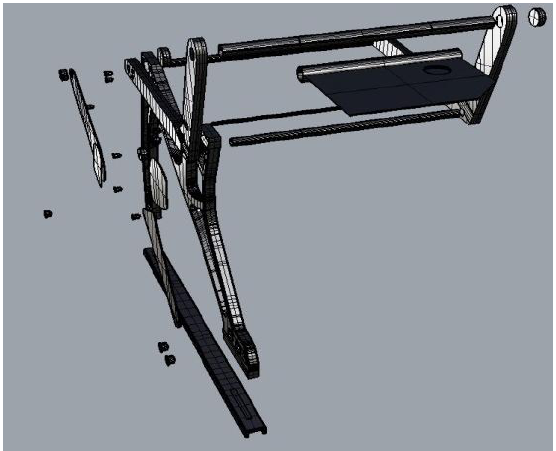
Figure 36. Individual back components.